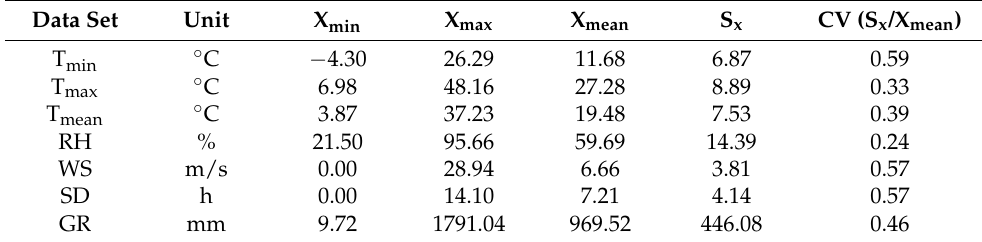
Table 2. Daily statistical parameters of data